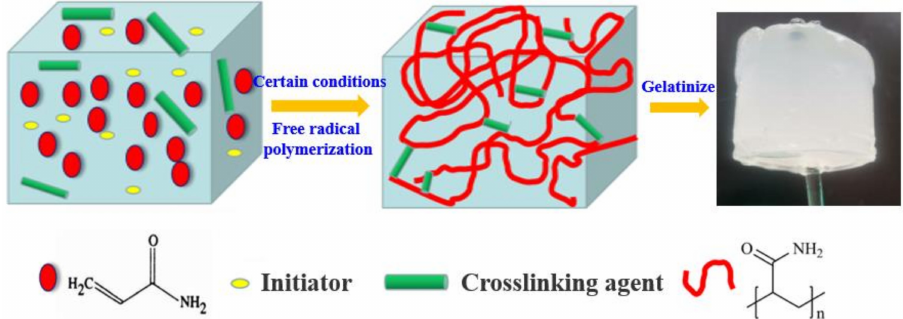
Figure 1. Schematic diagram of gel formation principle of shear thixotropic polymer gel.